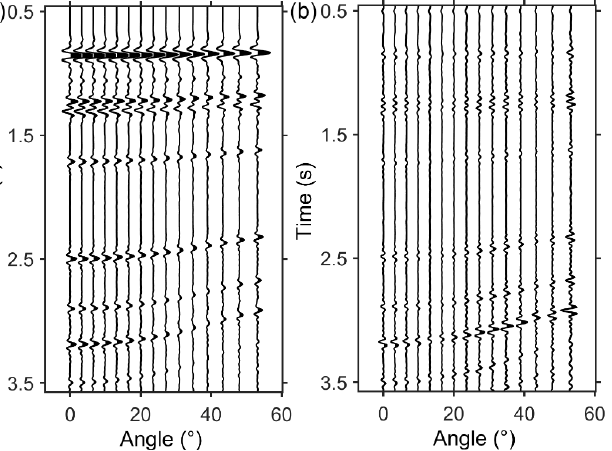
Figure 8. Comparison between the true model at 2.25 km and the inverted model from the noise-free data using the conventional AVO method: ( a ) P-wave velocity, ( b ) S-wave velocity, and ( c ) density. The black arrow indicates the location of the gas hydrate reservoir.